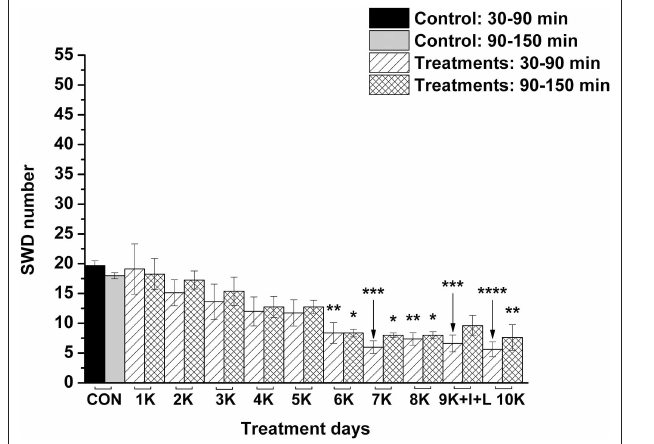
FIGURE 5 | The effect of combined administration of KEKS food (20% KEKS and 1% saccharin in standard rodent chow) with IP indomethacin plus IP LPS (10 mg/kg + 50 µ g/kg, respectively) on SWD number on the day of 9th KEKS food administration (9K + I + L; group 6). 1K, 1st KEKS food administration; 2K, 2nd KEKS food administration and so on; 9K + I + L, combined administration of KEKS food (K) with i.p. indomethacin (I) and i.p. LPS (L) on the day of 9th KEKS food administration; CON, control; SWD, spike-wave discharge. * p < 0.05, ** p < 0.01, *** p < 0.001, and **** p < 0.0001.